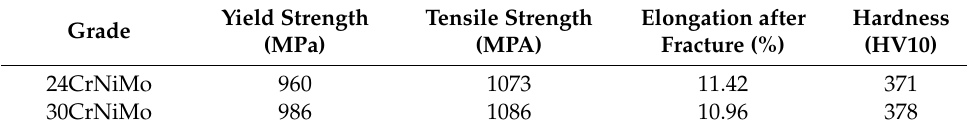
Table 4. Mechanical properties of 24CrNiMo alloy steel and 30CrNiMo steel.